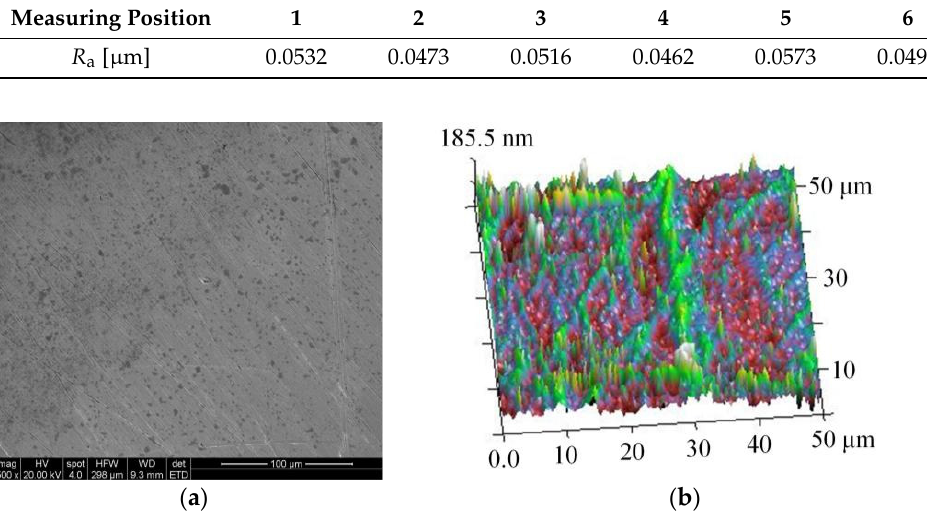
Figure 3. Observation examples of substrate surface morphology: ( a ) scanning electron microscopy (SEM); ( b ) atomic force microscopy (AFM). Table 2. Measurement results of surface roughness of substrate. Measuring Position